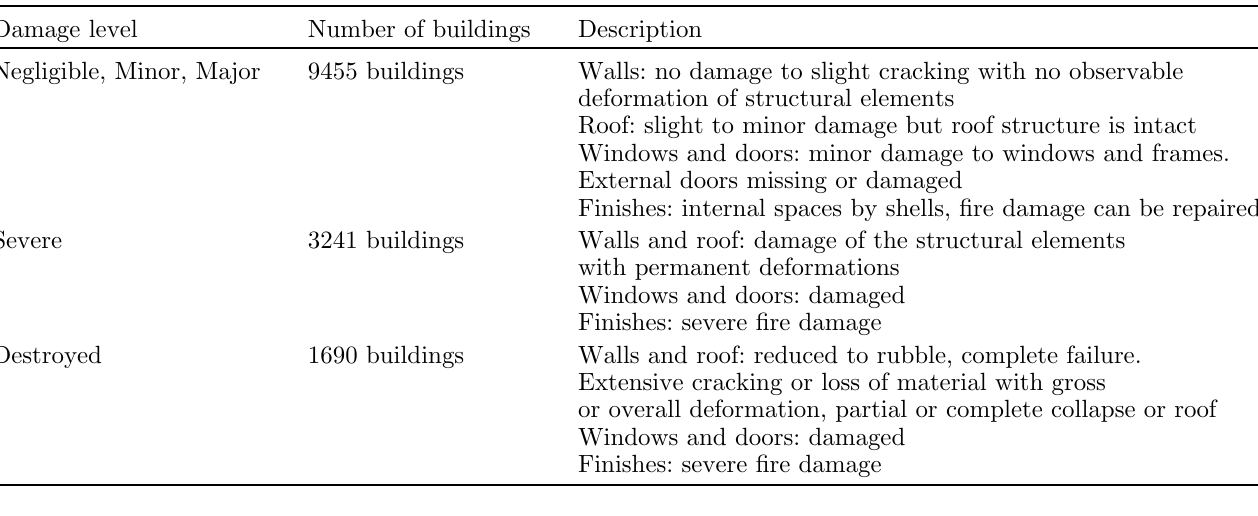
Table 1. Damage assessment levels and their descriptions.